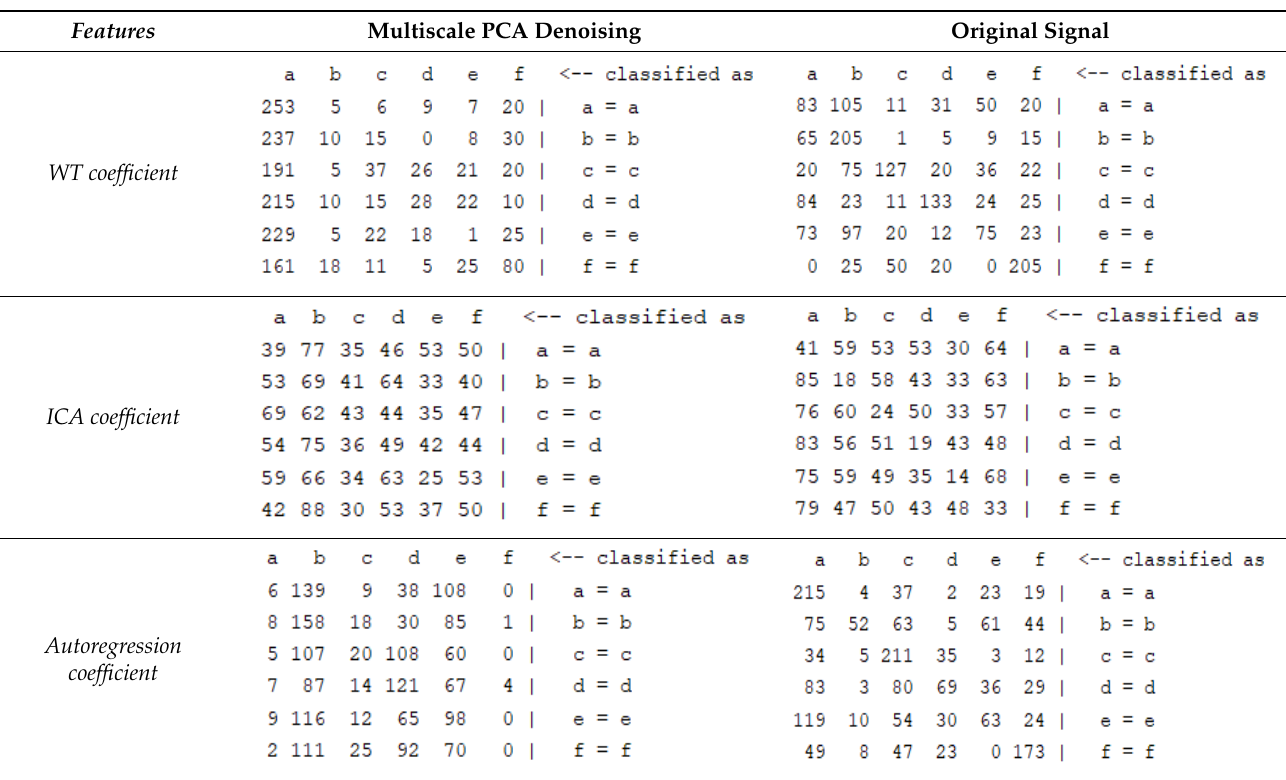
Table 5. The confusion matrix of naïve Bayesian method.